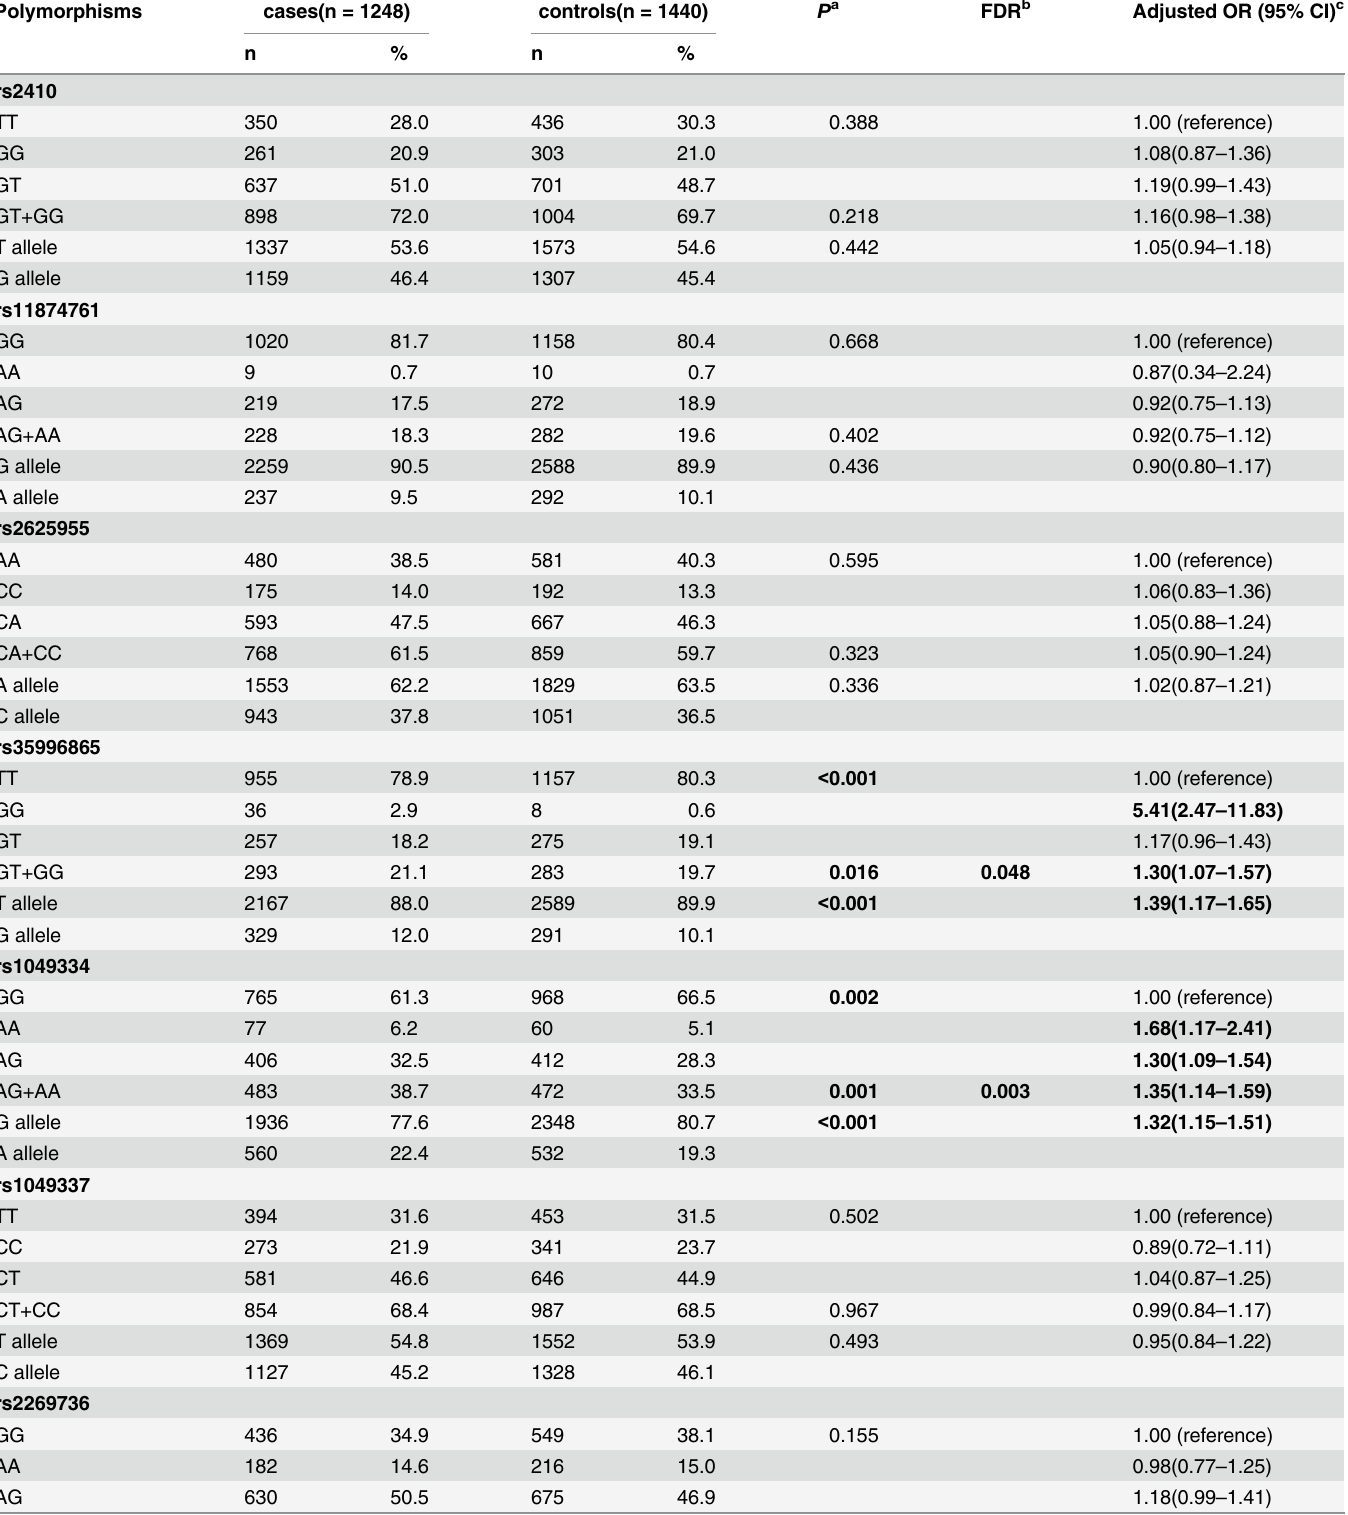
Table 3. The basic information of the genotyped polymorphisms in nine SNPs in the RhoA/ROCK1 and Cav-1 associated with the ccRCC